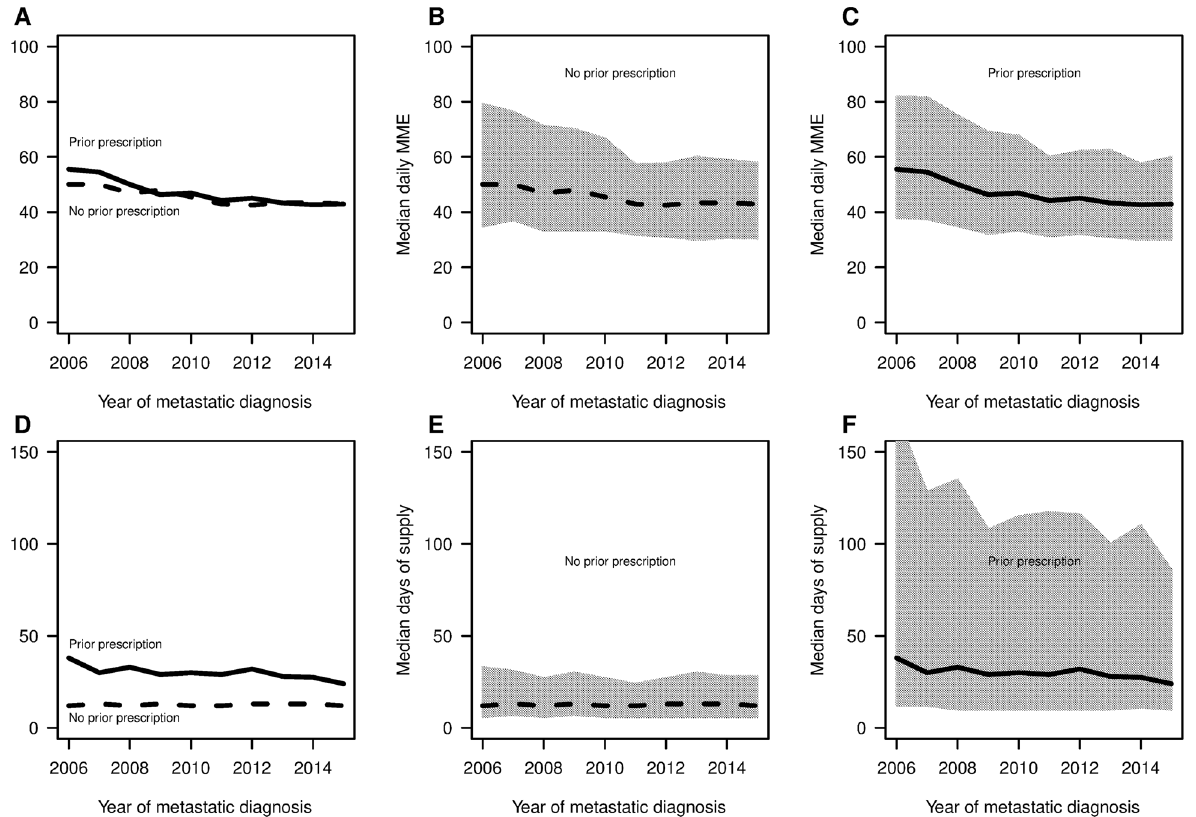
Figure 3. Median daily MMEs and median days of supply within 12 months of the metastatic diagnosis date by year stratified by use prior to the date (leftmost figures). The rightmost panels show the respective IQRs. Using R software (https ://www.R-proje ct.org/).